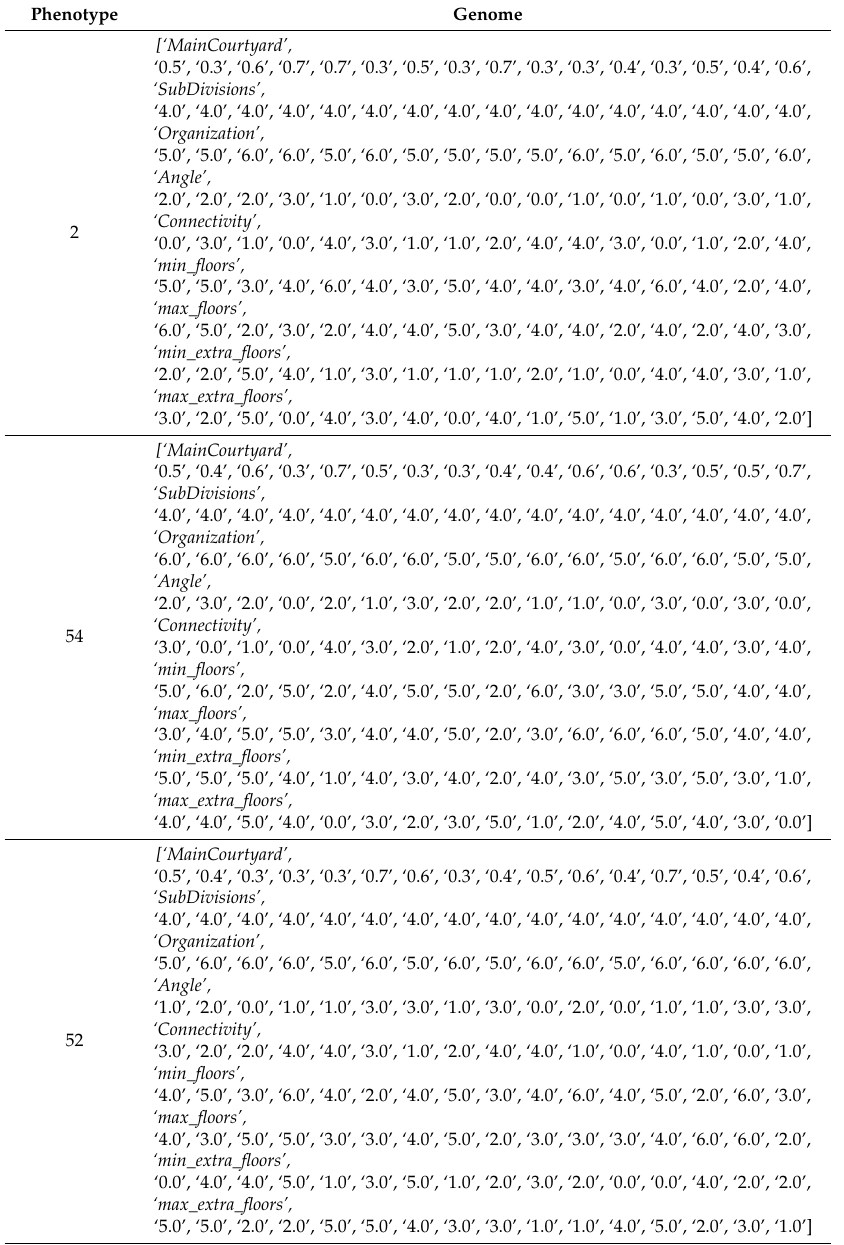
Table 2. The genomes of the phenotypes selected through the analysis of the relative difference rank (the body part of the phenotype onto which each gene sequence is applied to is presented in italics).